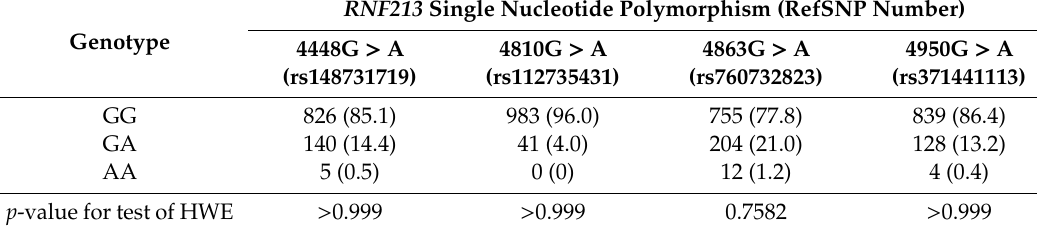
Table 2. Genotypes of RNF213 variants.